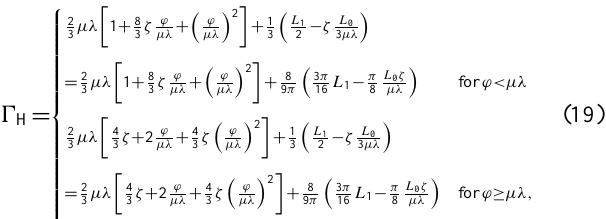
It is worth examining the tidal wave propagation in